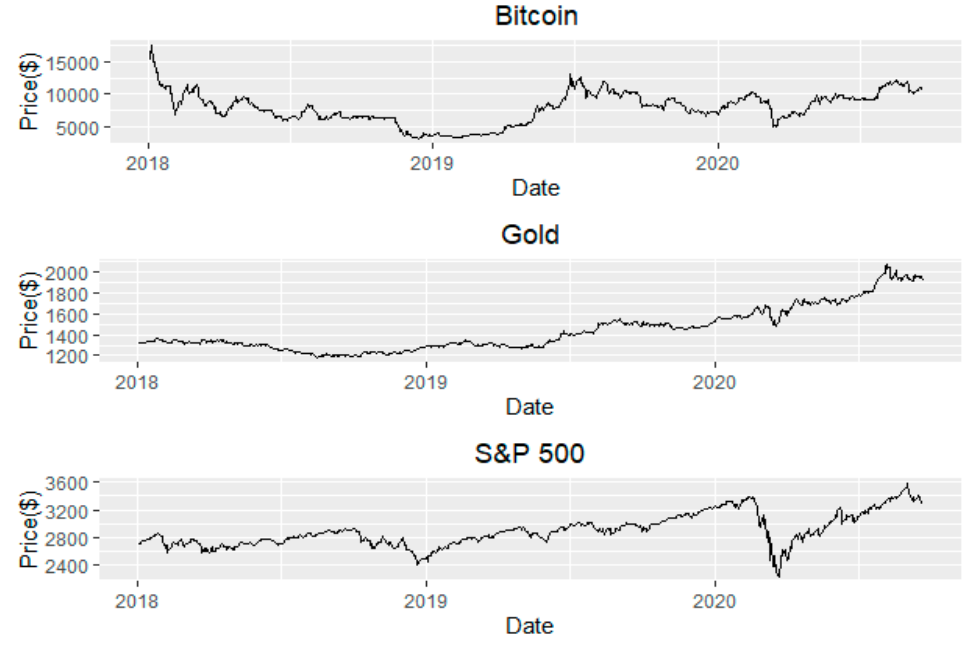
Figure 1. Prices of Bitcoin, Gold, and S&P 500. Table 1. Correlation coefficients of log-return of Bitcoin (LBTC), log-return of Gold (LGD), and log- returns of S&P 500 (LSP) with Pearson, Spearman, and Kendall.